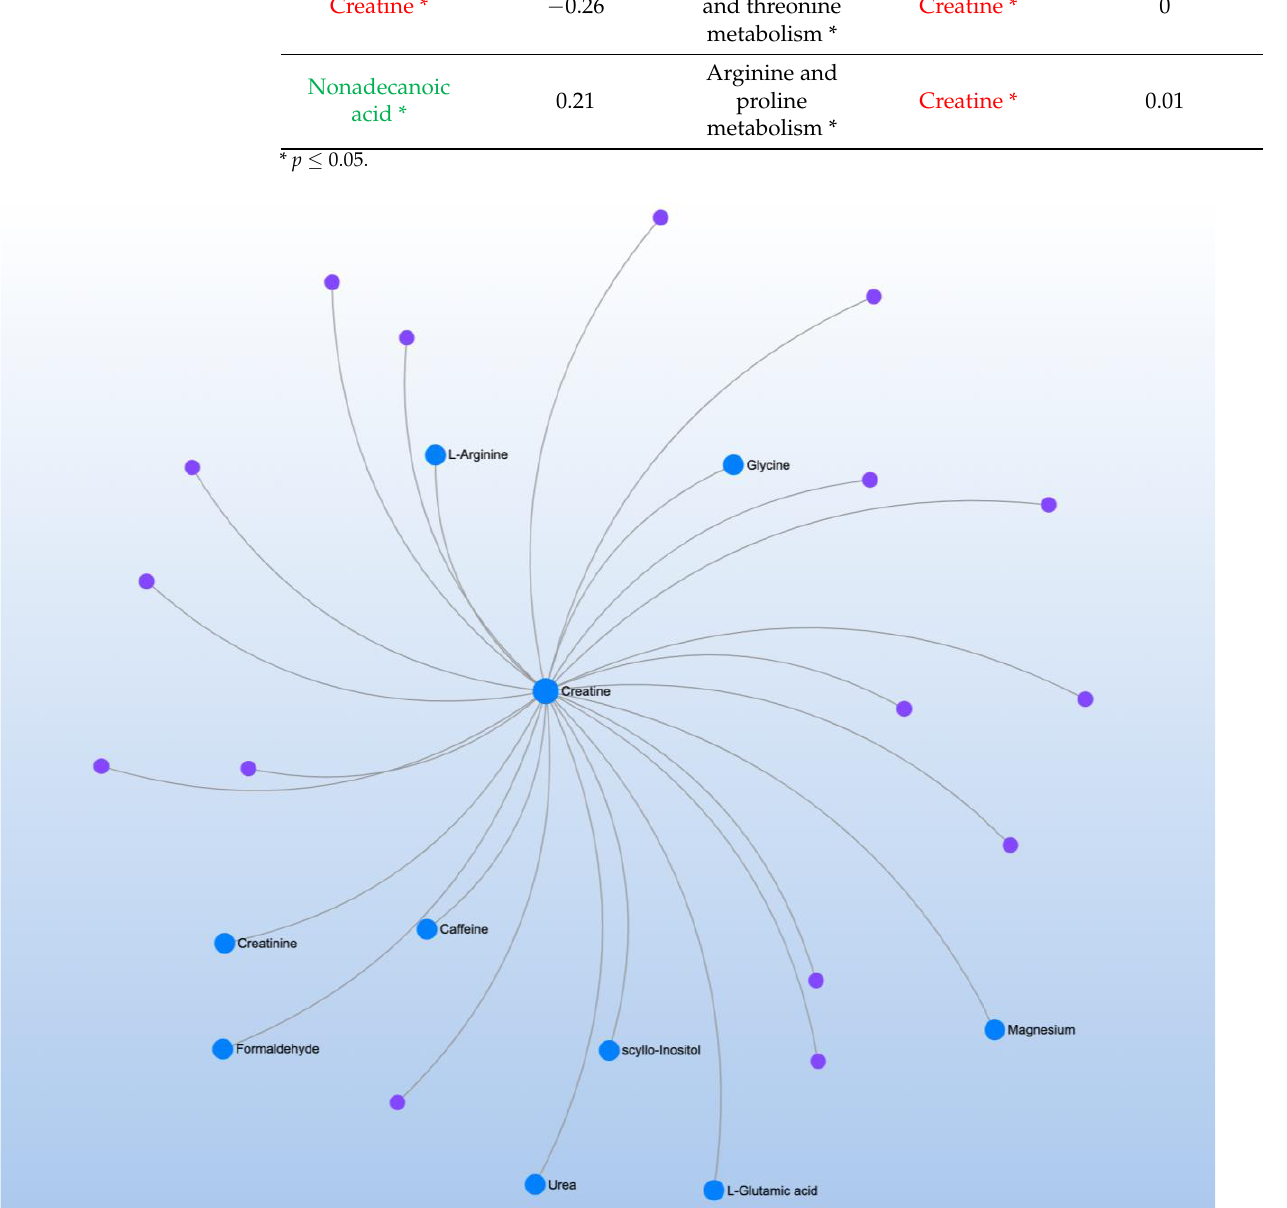
Figure 9. Metabolite-metabolite interaction network for significant metabolites that correlate to total glutathione redox ratio. Size of the node indicates importance in the network. The interaction analysis highlights the importance of creatine, an essential organic compound for maintaining and storing energy. Table 12. Metabolites and their pathways which correlate with the free glutathione redox ratio.